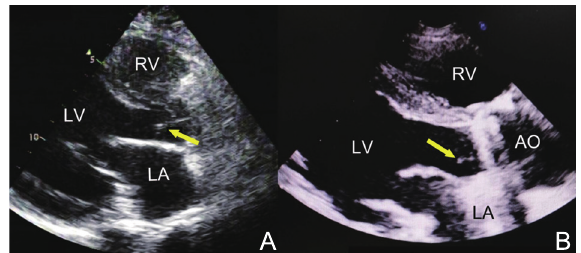
Figure 1 (A) prolapsed noncoronary cusp of the aortic valve (yellow arrow). (B) Vegetation-like lesions (yellow arrow) in prosthetic aortic valve. AO, aorta; LA, left atrium; LV, left ventricle; RV, right ventricle.